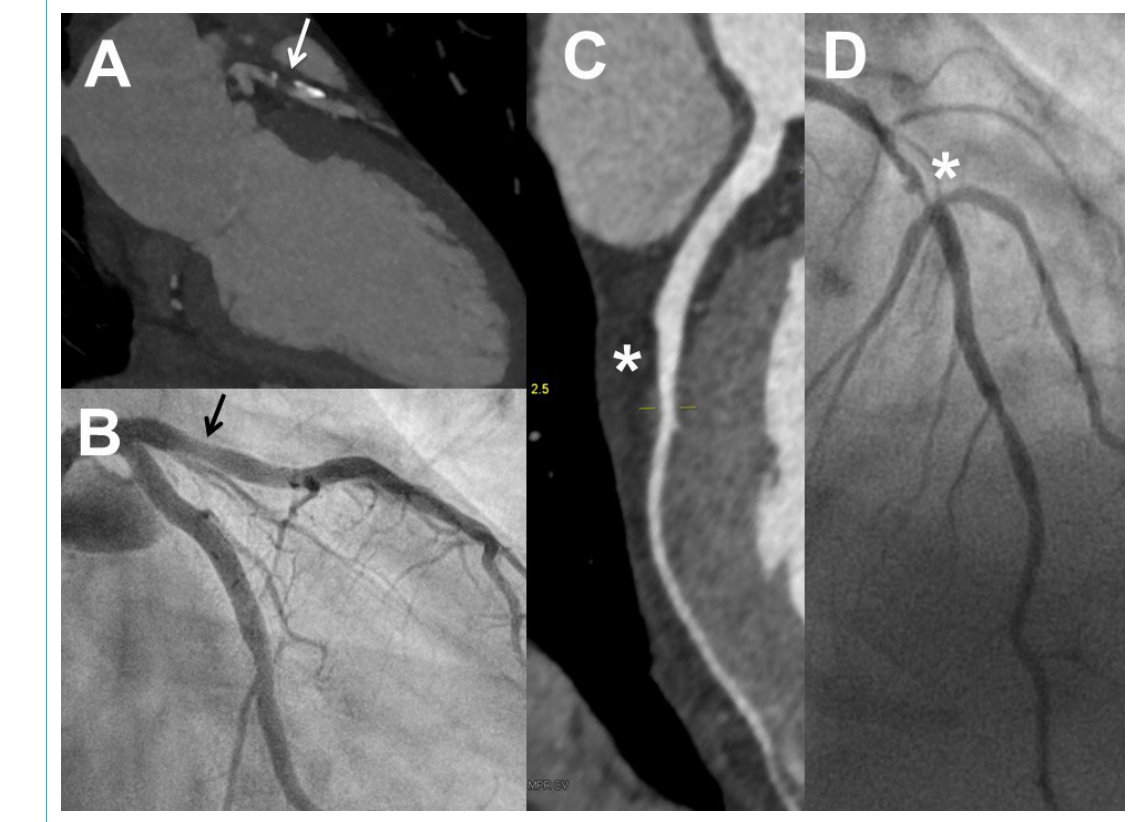
Figure 3: Examples of coronary computed tomography (CCTA) and invasive coronary angiography (ICA) in two patients with non-optimal cor- relation of the two methods: Frist patient (female, 54 years) with severe stenosis of the proximal left anterior descending artery in CCTA (panel A, arrow) but eccentric plaque without significant stenosis in ICA (panel B, arrow; lesion looking less relevant in other projections, absolutely normal fractional flow reserve). Second patient (female, 61 years) with no significant stenosis of the mid left anterior descending artery in CC- TA (panel C, asterisk) but severe stenosis of the mid left anterior descending artery in ICA (panel D,